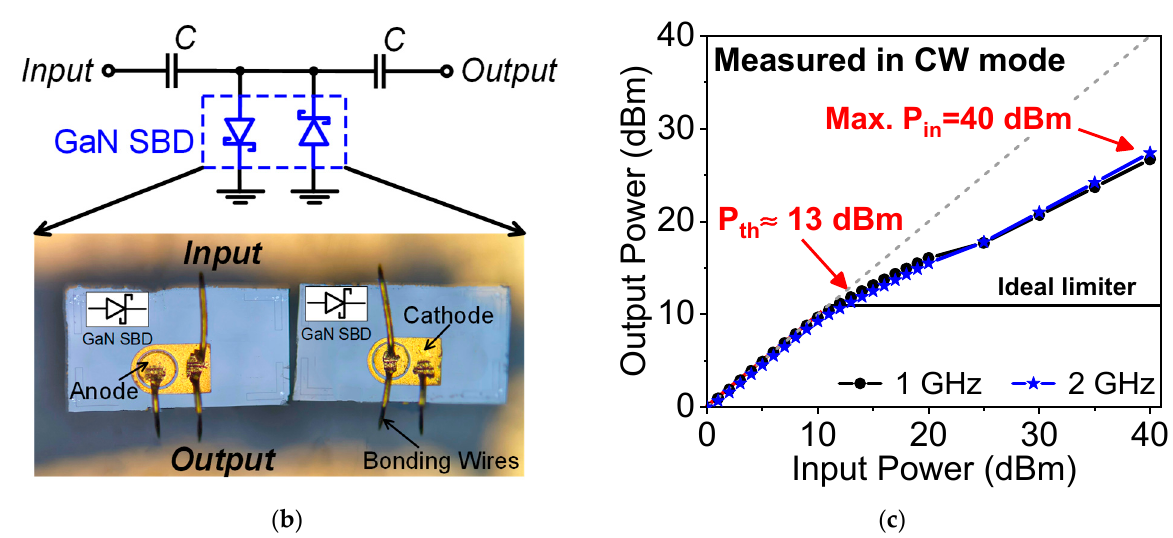
Figure 6. ( a ) Radio transceiver block diagram. ( b ) Circuit schematic and microscope image of the one-stage anti-parallel diode limiter using the wire-bonded GaN SBD. ( c ) Output power versus input power for the GaN SBD limiter at 1 GHz and 2 GHz.